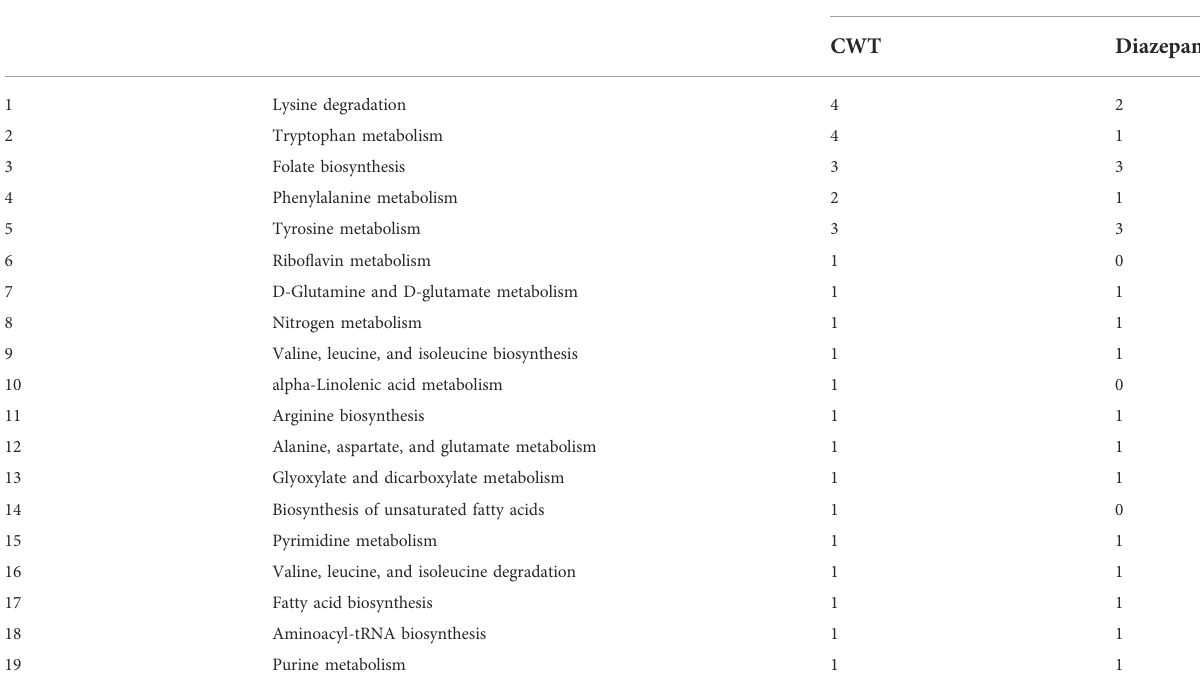
TABLE 2 Comparison of biomarker quantity and metabolic pathway affected by CWT and diazepam. No. Pathway